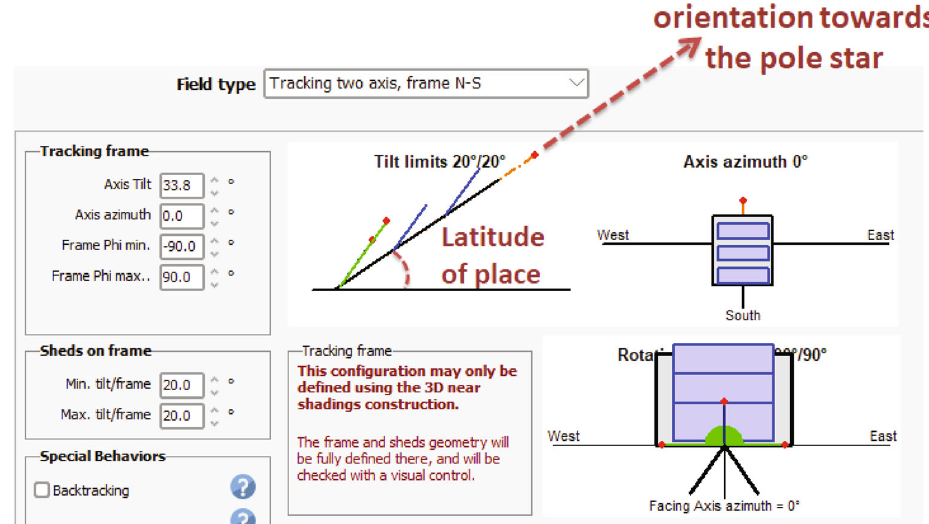
Figure 20: Equatorial biaxial solar tracker model (the proposed